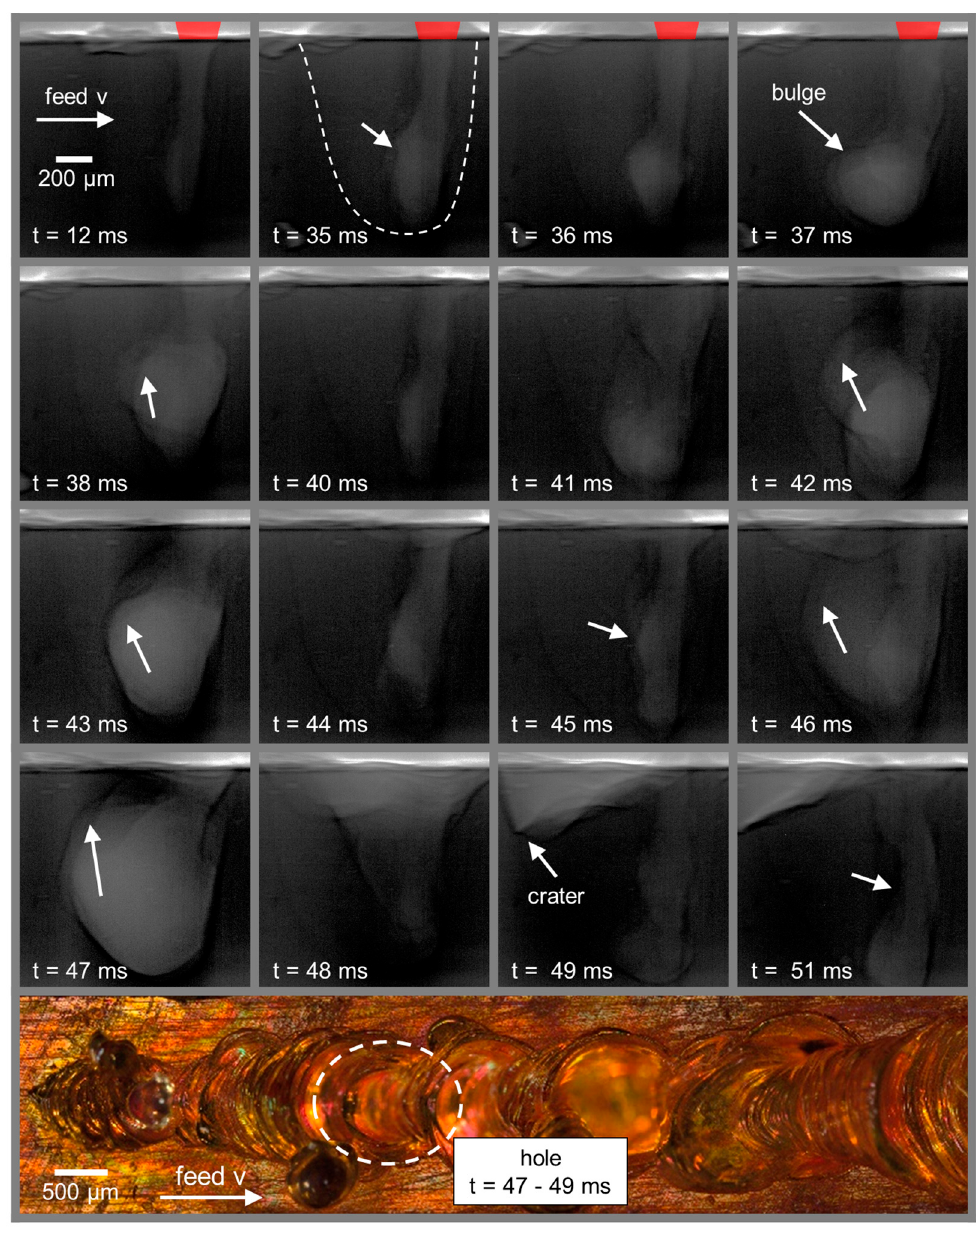
Figure 8. (Upper) X-ray video sequence of laser beam welding of copper using 1030 nm laser radi- Figure 8. ( Upper ) X-ray video sequence of laser beam welding of copper using 1030 nm laser ation, P = 2500 W, v = 66.7 mm/s; ( lower ) corresponding top view of the weld seam. radiation, P = 2500 W, v = 66.7 mm/s; ( lower ) corresponding top view of the weld